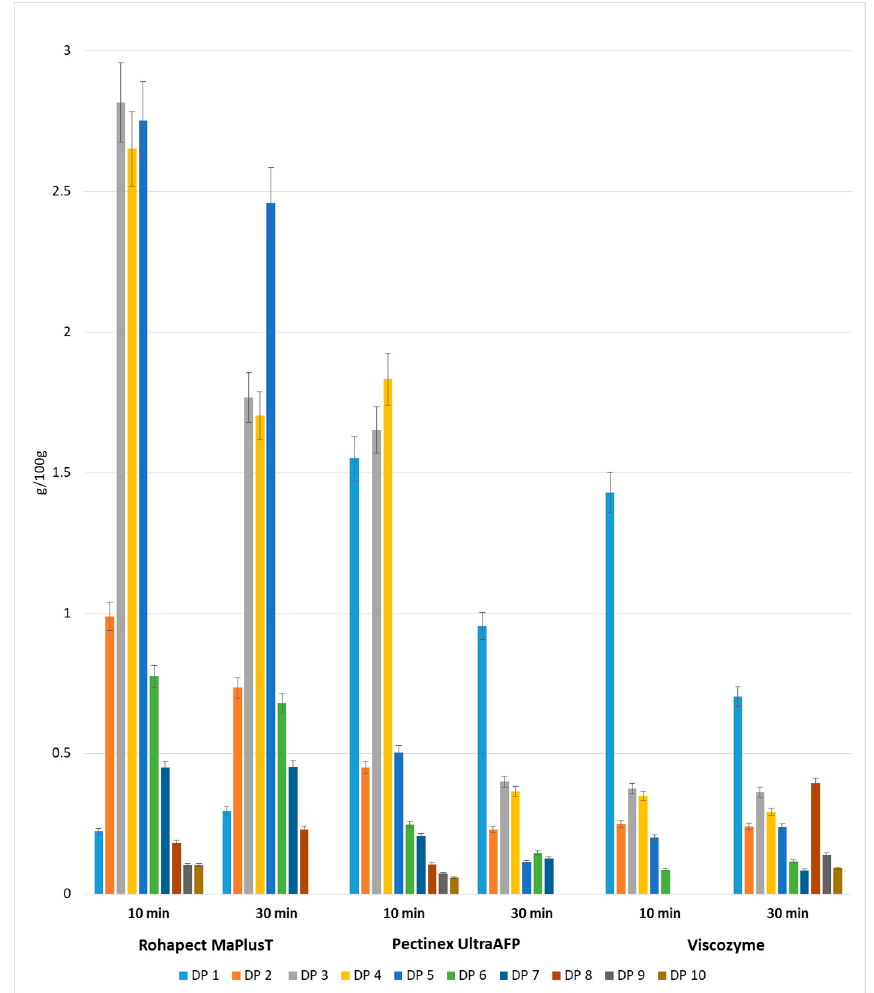
Figure 3. Yields of oligosaccharides with different degrees of polymerization obtained after mild acid and enzymatic hydrolysis of apple pomace. Data represent mean from two independent experiments repeated three times. Error bars denote SD.